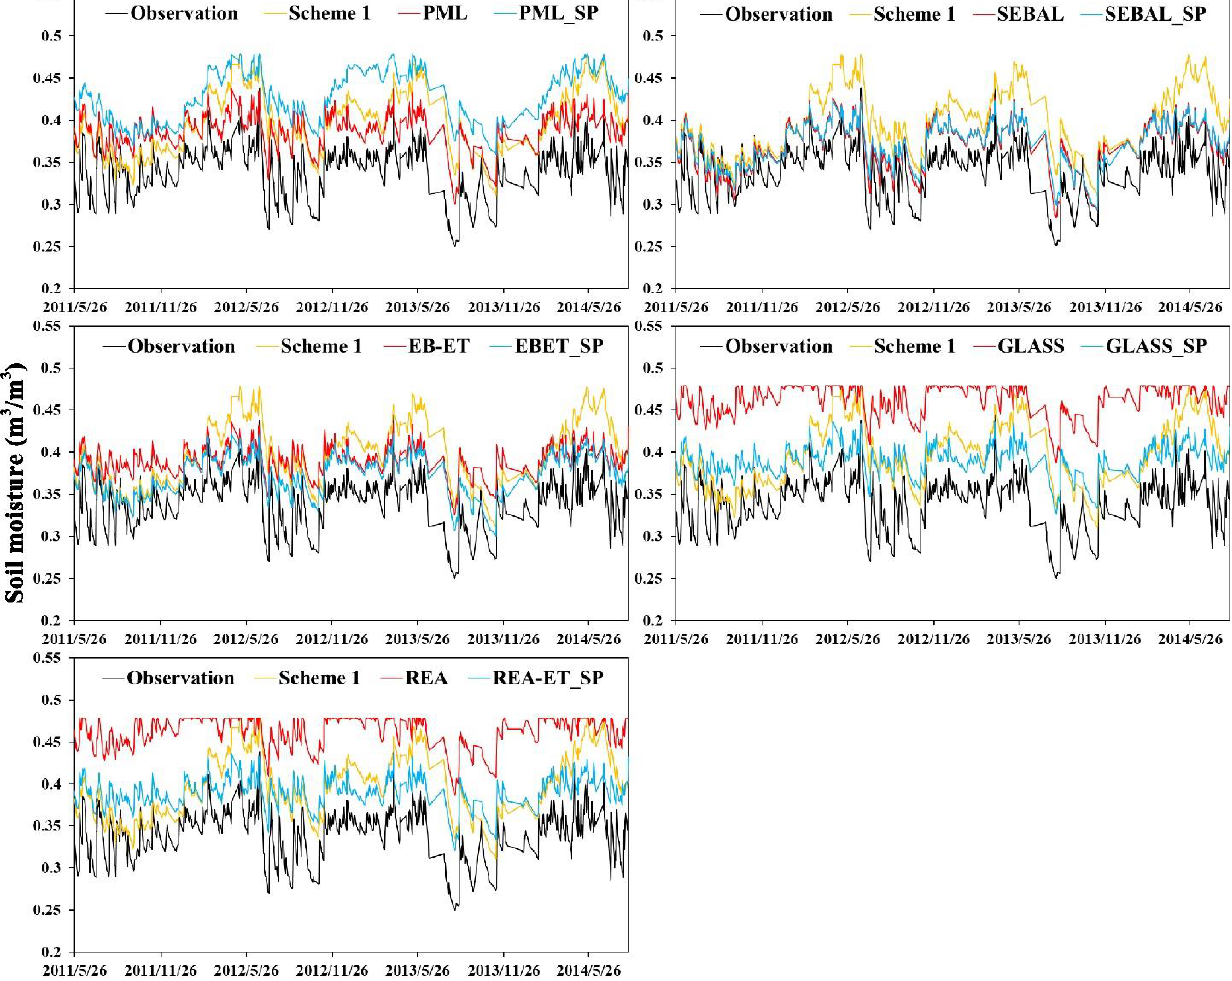
Figure 11. Time series of 0–40 cm depth soil moisture simulation provided by all calibration cases at the No.14 soil moisture station.